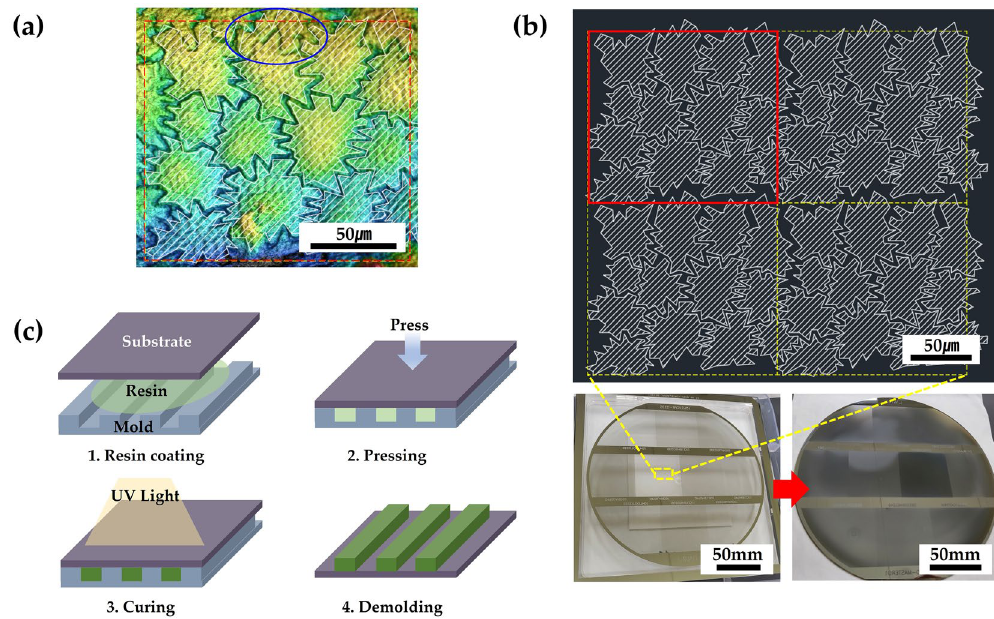
Figure 5. The two-step replication process of Allium seed surfaces. ( a ) Microscopic image of measured Allium seed surface; ( b ) first step entails the preparation of Si master mold designed by simplified modeling of seed sur-faces extracted from the measured image and ( c ) second step involves the replication of the polymeric seed surfaces from the Si master mold using the NIL